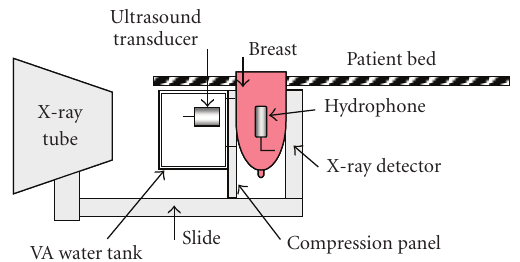
Figure 1: Schematic of combined vibro-acoustography-mammog- raphy system, “reproduced with permission from